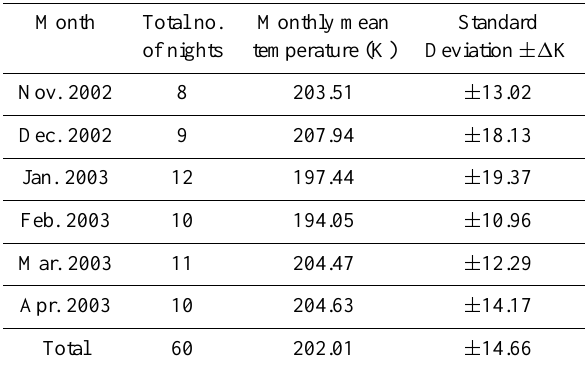
Table 1. Nights of observation and their monthly mean temperature.